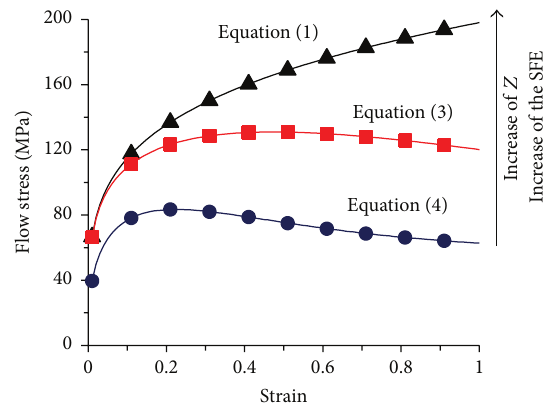
Figure 1: Typical responses of metals subjected to deformation and equations used to describe these